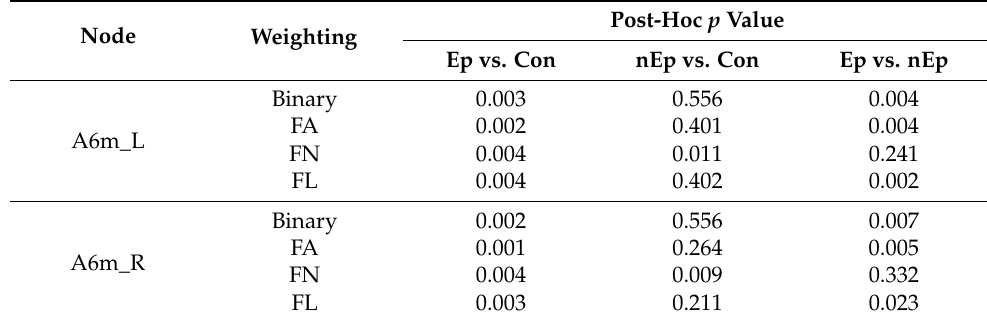
Table 6. Nodal efficiency difference of A6mL and A6mR.